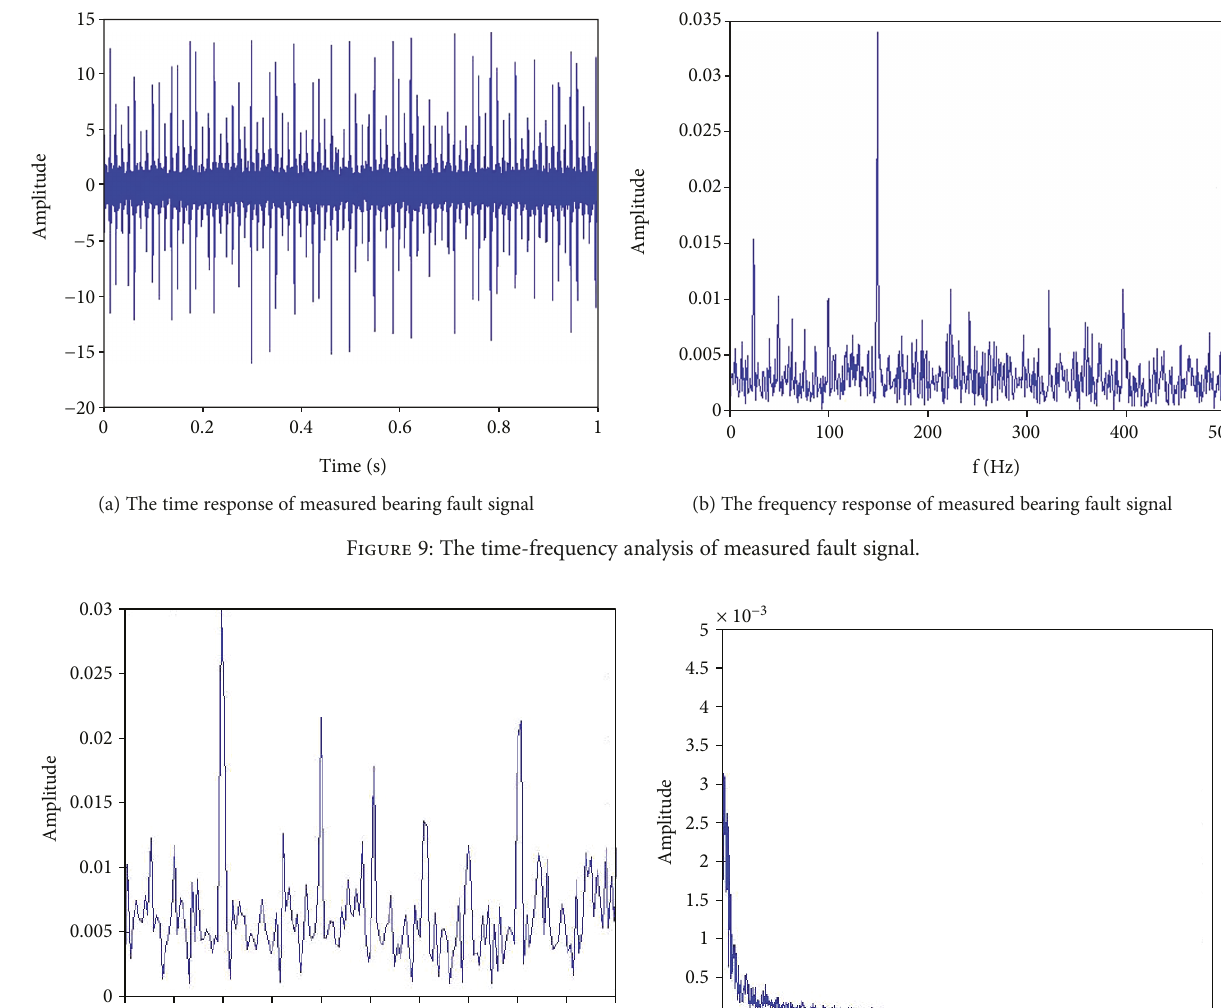
Figure 12. Meanwhile, the rotational frequency f r can also